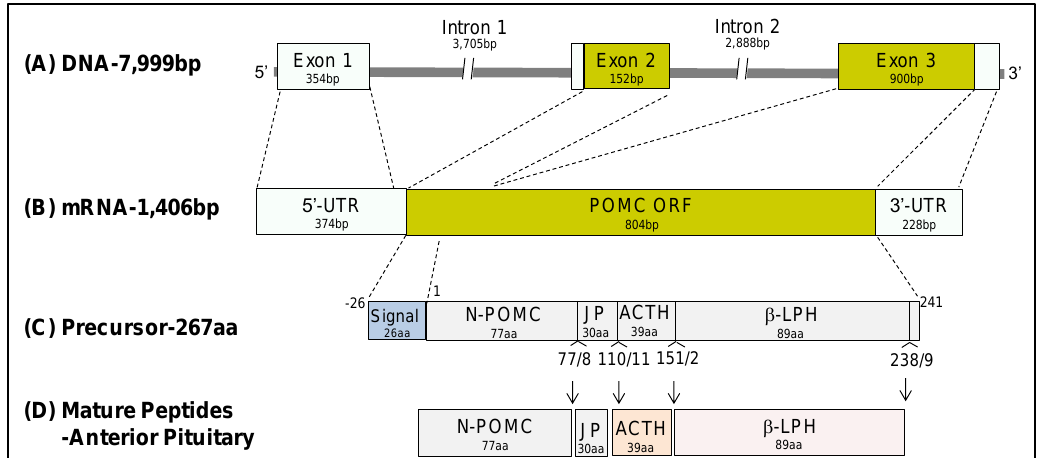
Figure 2. Gene structure and the bioactive peptides derived from the human proopiomelanocortin (POMC) gene. ( A ) The human POMC gene located on chromosome 2p23.3, spans 7999 bp on the reverse strand, and contains three exons and two introns. ( B ) The POMC transcript is processed into a 1406 bp mature mRNA with a 804 bp open reading frame (ORF). ( C ) The precursor protein of POMC contains 267 amino acids. The N-terminus 26aa signal peptide is cleaved during maturation, and the remaining region is further processed into several peptides in a tissue-specific manner. ( D ) In the anterior pituitary, POMC gives rise to a 16kDa N-POMC (also known as Pro- γ -MSH), joining peptide (JP), ACTH and beta-lipotropin ( β -LPH).